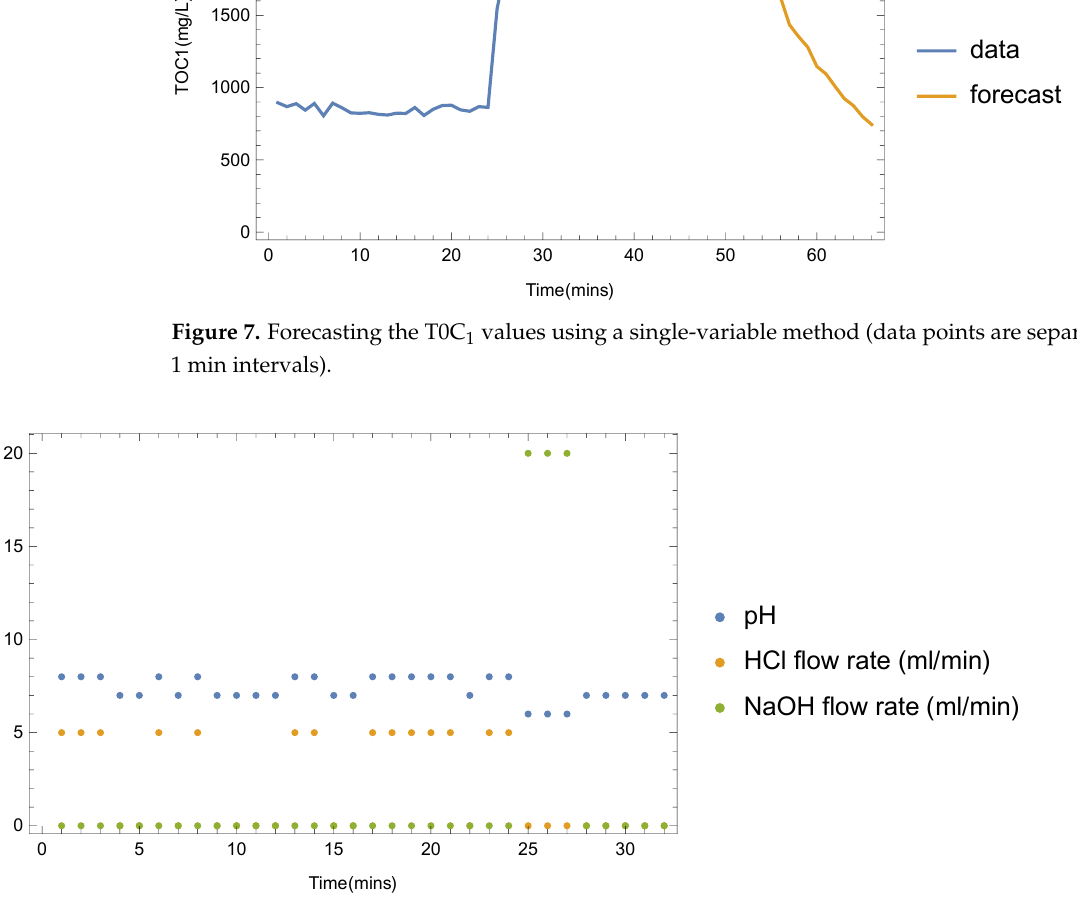
Figure 8. HCl and NaOH sensor values depicted against measured pH over a 30 min